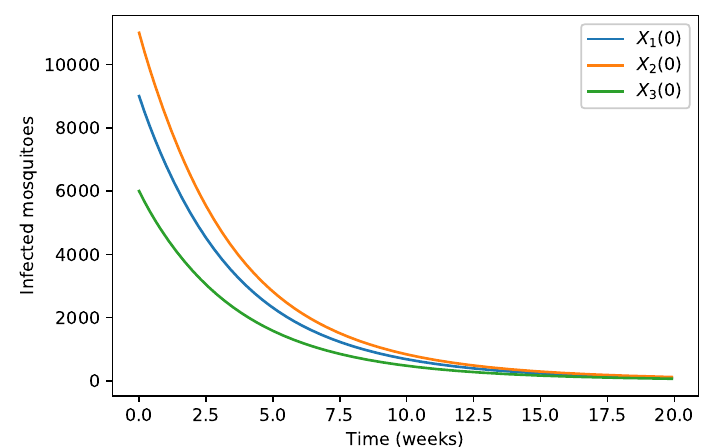
Figure 2. The solution of Model (5) tends toward the disease-free equilibrium. In this figure, we show the evolution of the infected mosquitoes population for different initial conditions.